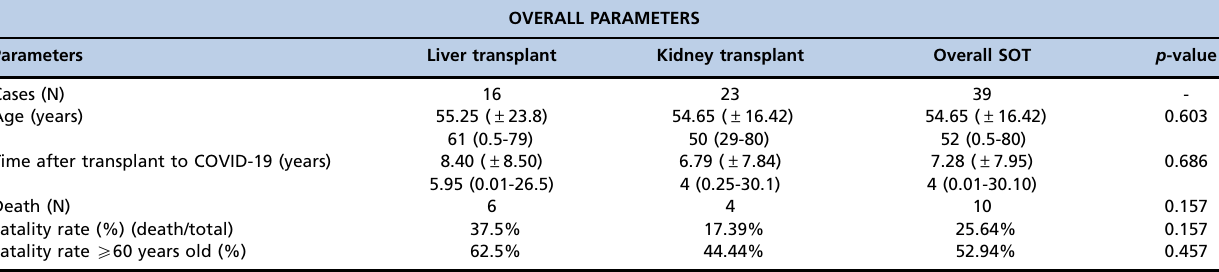
Table 3 - COVID-19 infection in SOT, LT, and KT patients. Overall parameters and prevalence/fatality rate in COVID-19 in SOT, liver and kidney patients. OVERALL